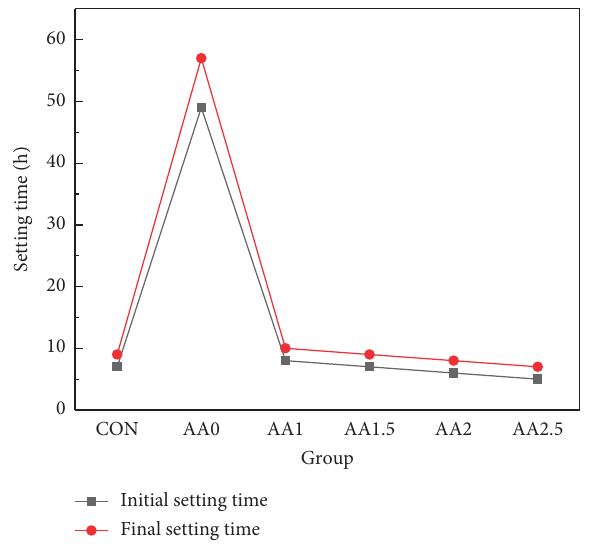
Figure 2: Results of setting time determination.